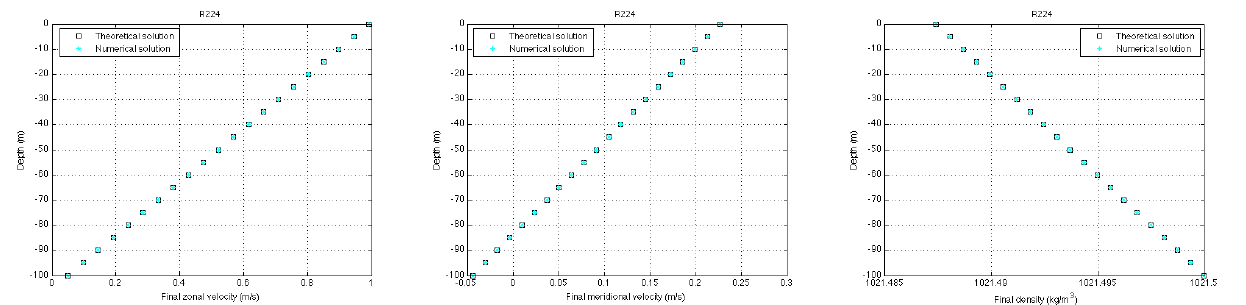
Fig. 11. Test 2: steady zonal velocity, meridional velocity and density profiles (from left to right) for model R 224.